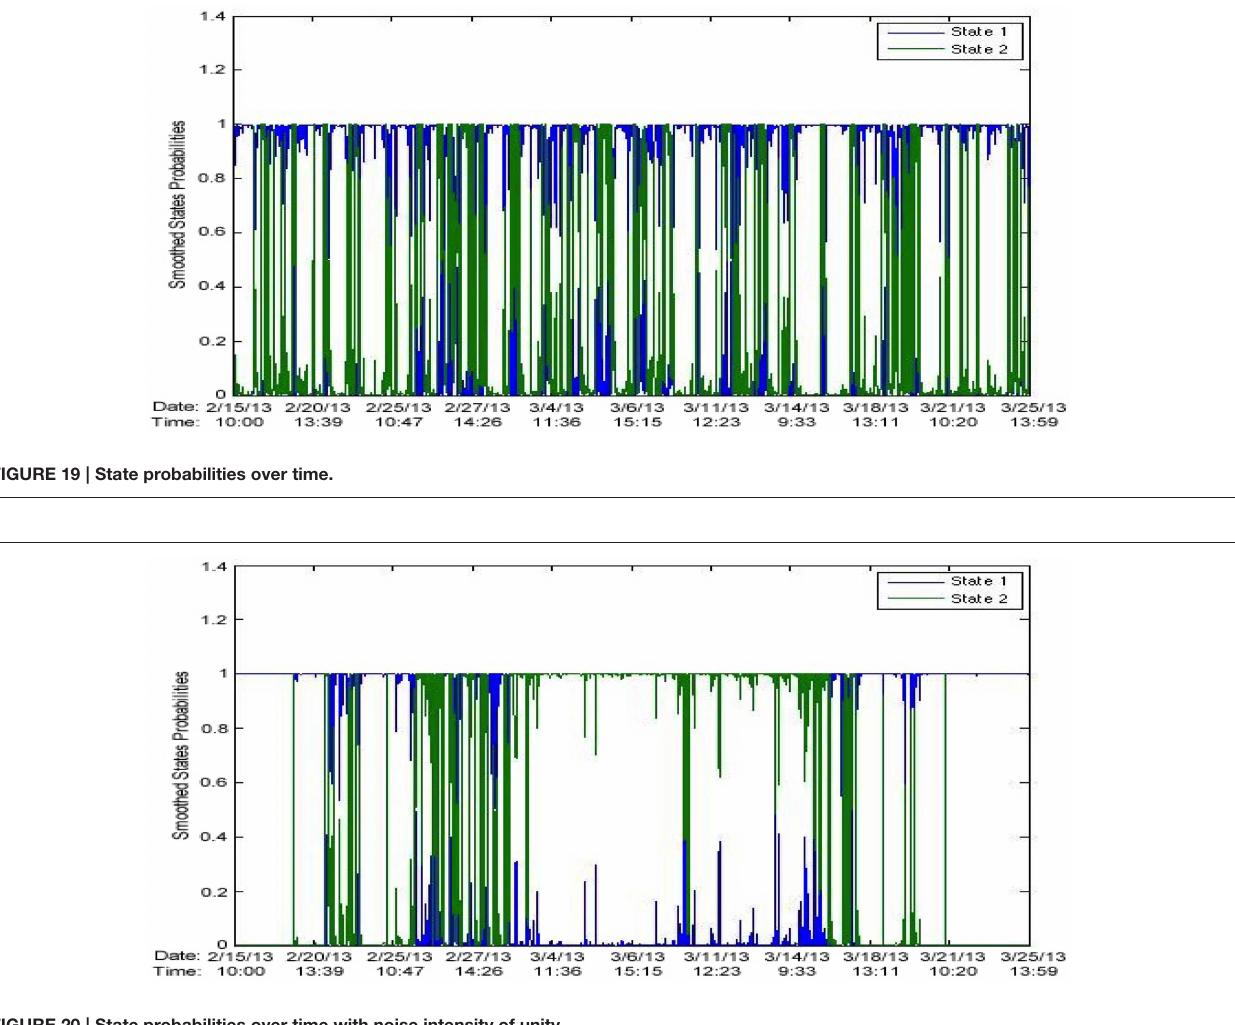
FIGURE 20 | State probabilities over time with noise intensity of unity.